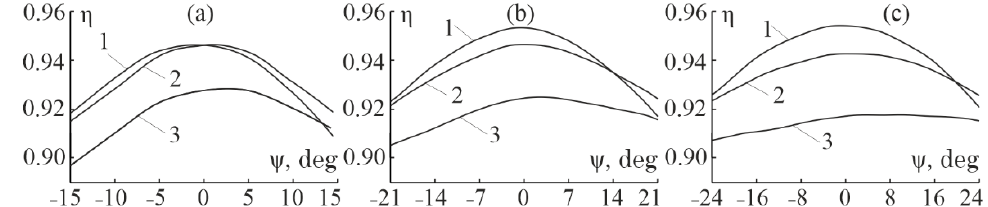
Figure 2. The calculated DE dependence on the angle of incidence for microstructures No. 3 of Table 1. At λ = 0.4 μ m (1); at λ = 0.55 μ m (2); At λ = 0.7 μ m (3). ( a – c ) correspond to P = 10, P = 20 and P = 30.